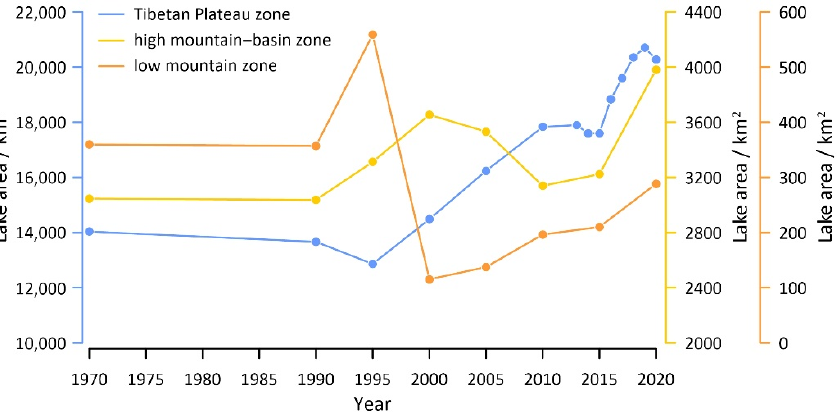
Figure 3. Variation trends of lake area in three geomorphic zones in CEA over the past 50 years.